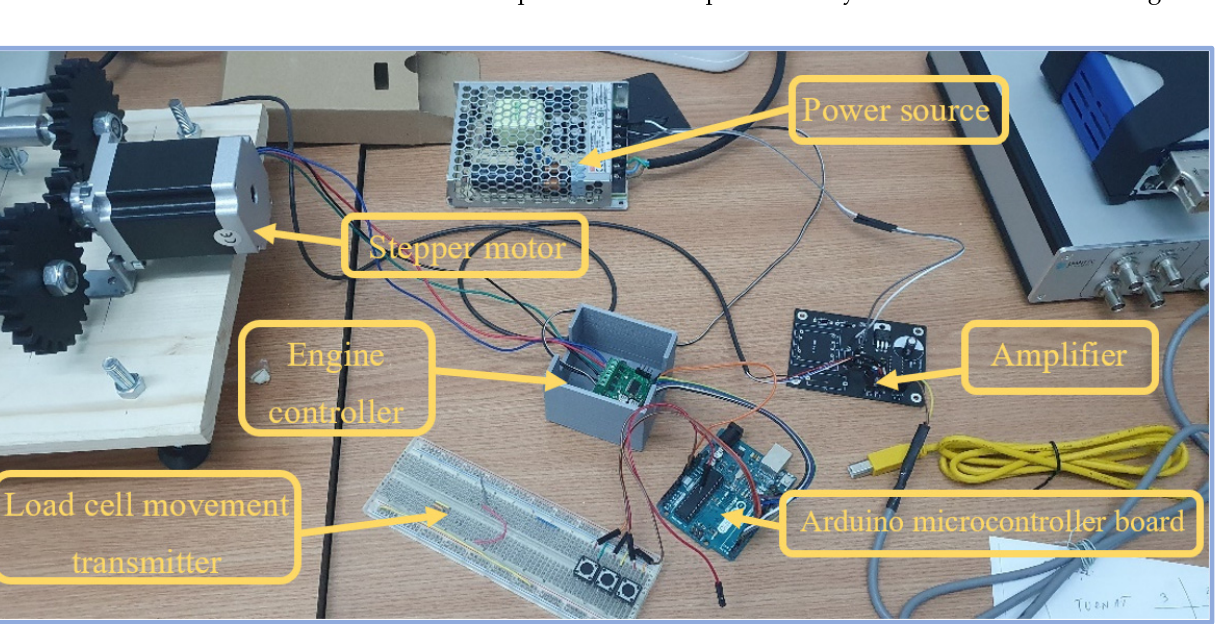
Figure 2. Main components of the experimental set-up for the single-ply tensile testing.